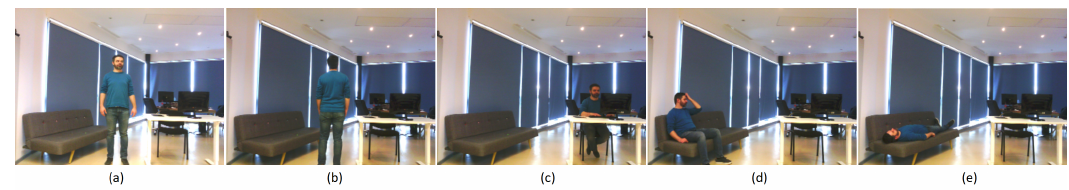
Figure 9. People postures used in the dataset.